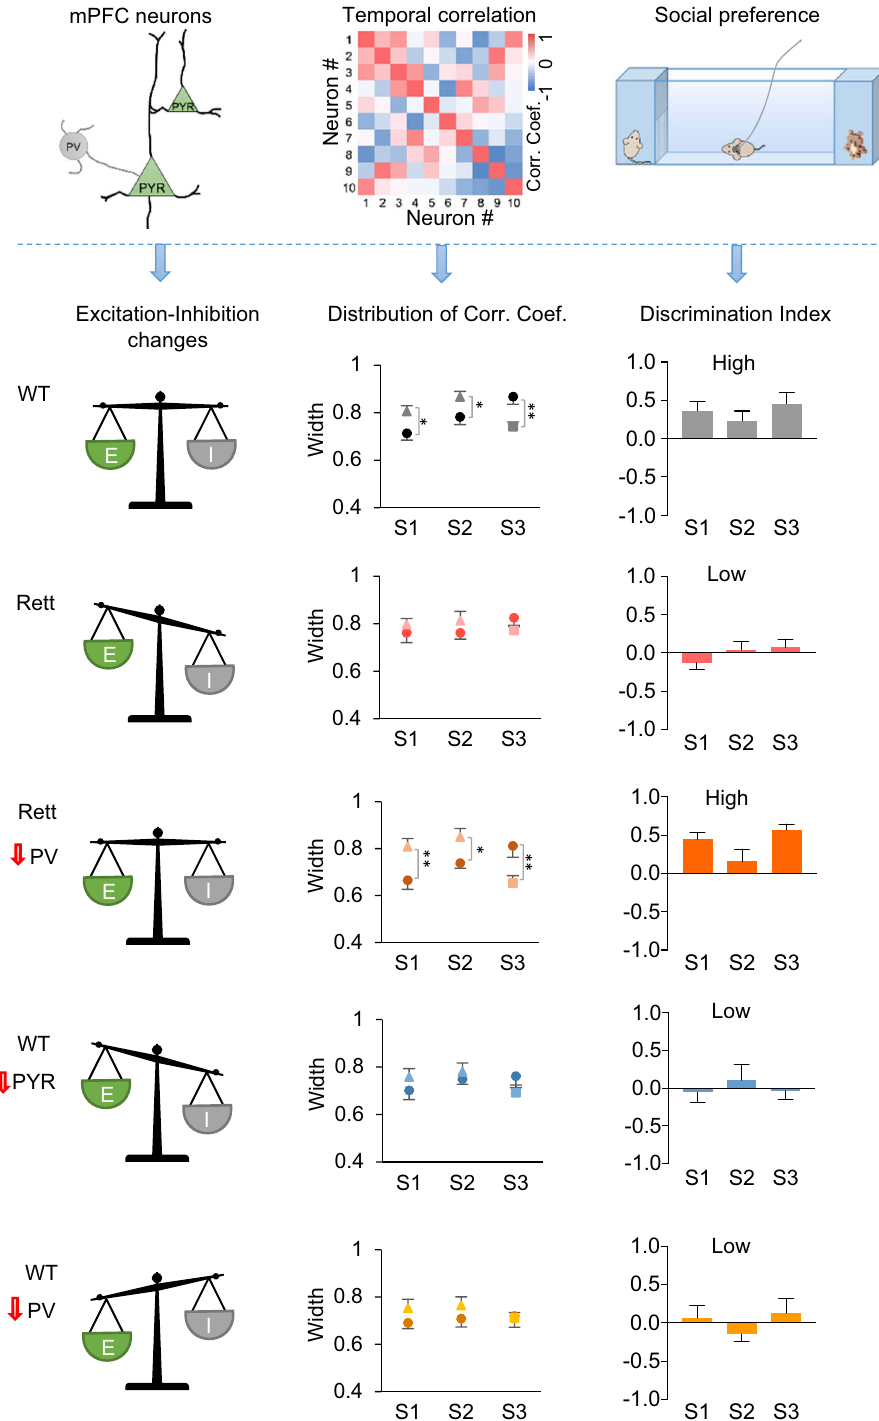
Fig. 7 The relationship of changes in E/I balance at the cellular, circuit, and behavioral levels. The cell-level E/I imbalance (left) in the mPFC impairs circuit-level pattern decorrelation, leading to the behavioral loss of social preference. The correction of cell-level E/I imbalance (left) in the mPFC of Mecp2 -de fi cient Rett mice restores circuit-level pattern decorrelation and restores social preference. Source data are provided as a Source Data fi